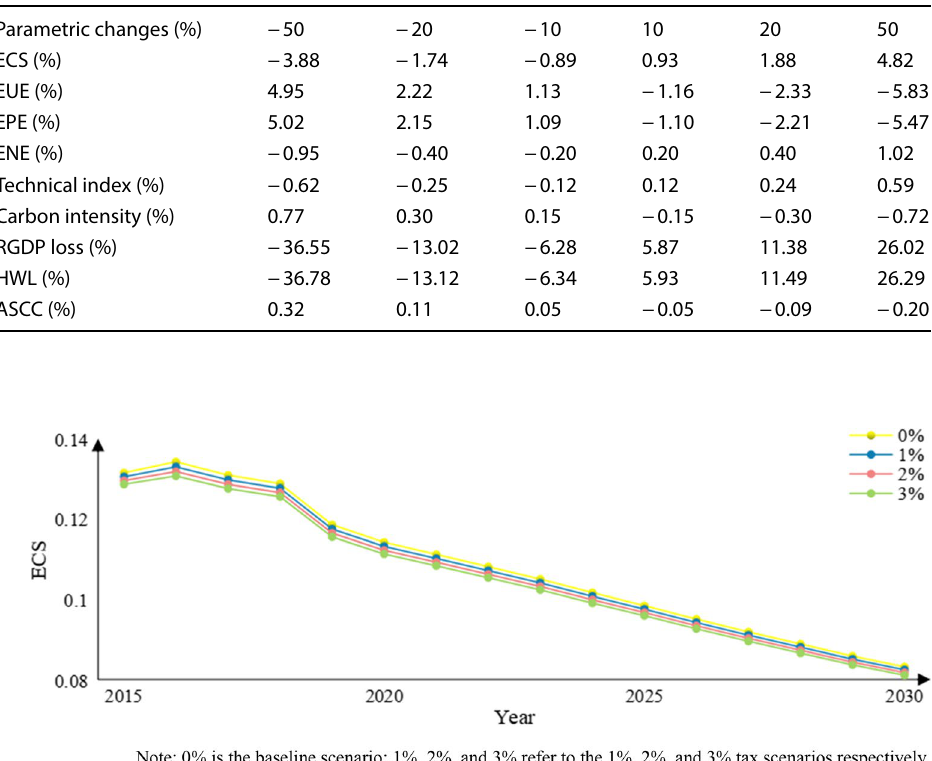
Fig. 11 The EUE in the base- line and tax scenarios